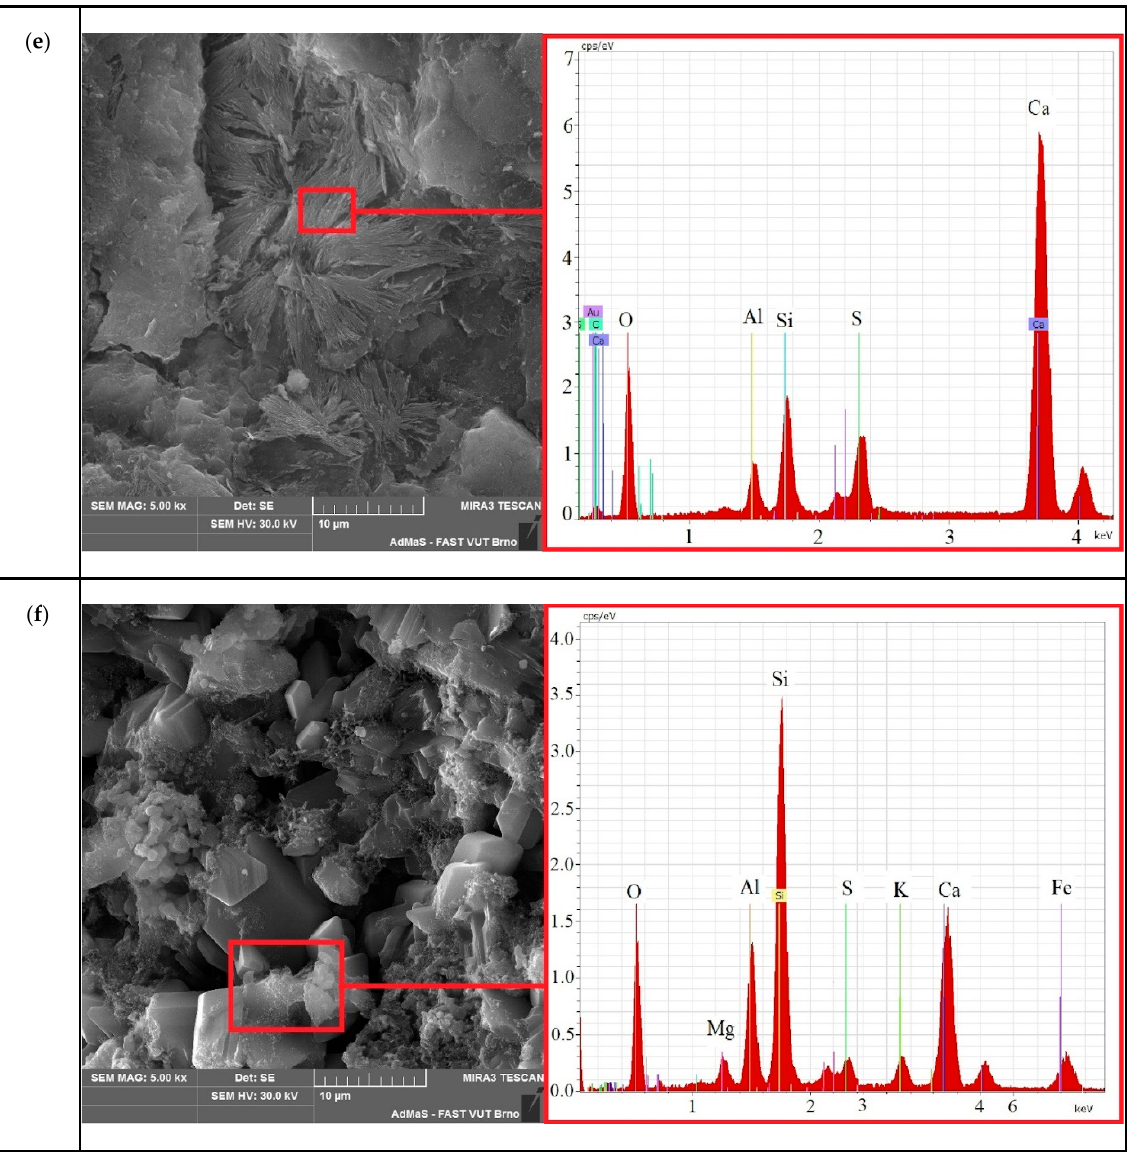
Figure 4. Scanning electron microscopy of samples of the control ( a , c , e ) and electrically conductive compositions on ( b , d , f ): (I) day 56 ( a , b ); (II) day 112 ( c , d ); and (III) day 224 ( e , f ).